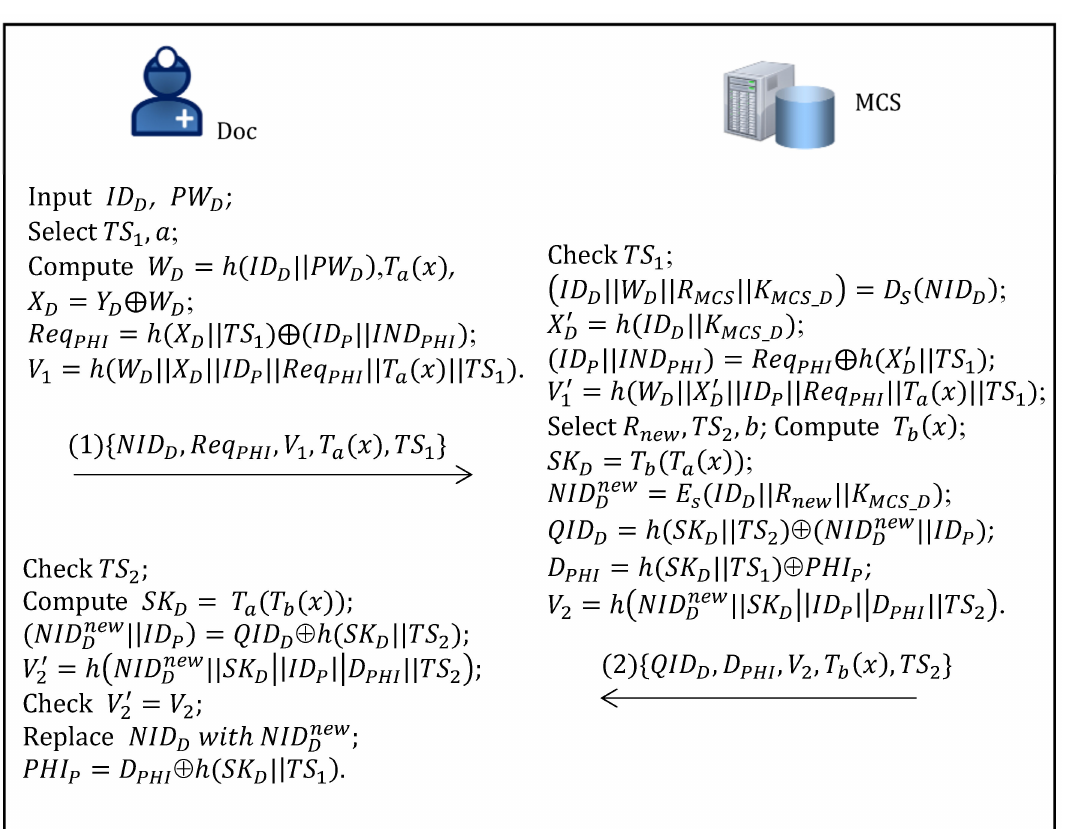
Figure 3. The processes of emergency exception handling phase of the proposed